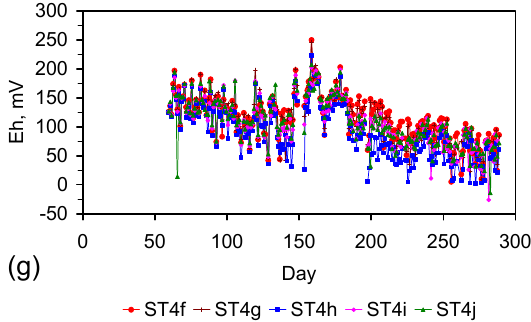
Figure C8. ( a ) pH vs. Eh; ( b ) EC vs. day, ST4a–ST4e; ( c) EC vs. day, ST4f–ST4j; ( d ) pH vs. day, ST4a–ST4e; ( e ) pH vs. day, ST4f–ST4j; ( f ) Eh vs. day, ST4a–ST4e; ( g ) Eh vs. day, ST4f–ST4j. ZVM TP = copper sheathed pellets (15 mm OD) placed in water at a concentration of ST4a = 50 g·L − 1 ; ST4b = 55.5 g·L − 1 ; ST4c = 50 g·L − 1 ; ST4d = 63.5 g·L − 1 ; ST4e = 87.5 g·L − 1 ; ST4f = 44 g·L − 1 ; ST4g = 49 g·L − 1 ; ST4h = 66.5 g·L − 1 ; ST4i = 36 g·L − 1 ; ST4j = 44.5 g·L − 1 . Reactor Size: 0.3 L; Feed Water volume: 0.2 L.